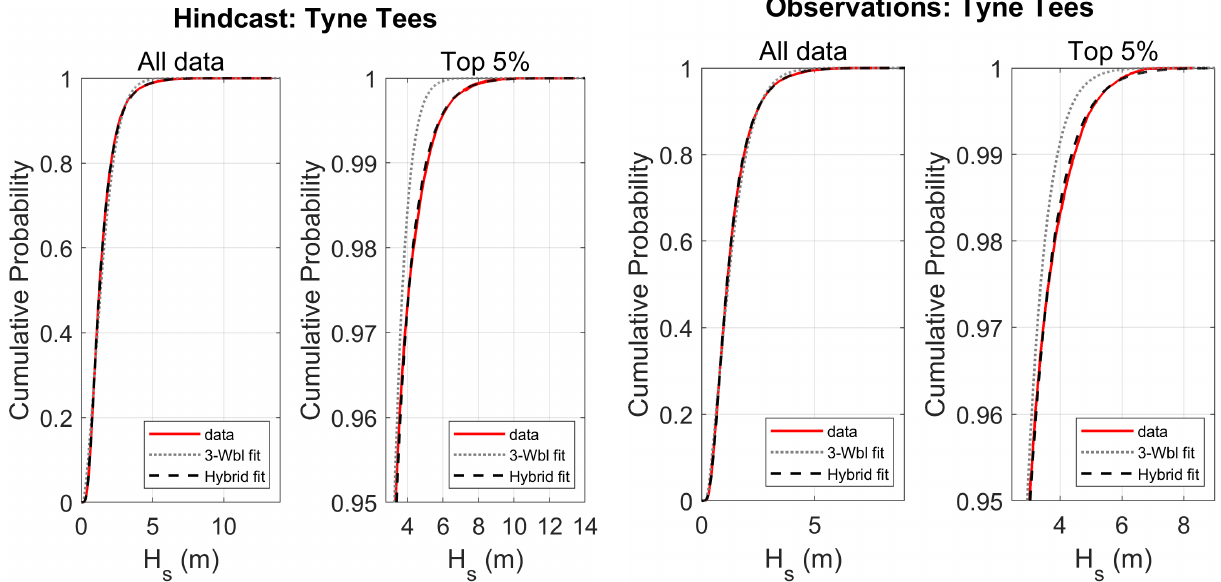
Figure 5. Goodness-of-fit plots for H s in the I-FORM method, showing both the 3-parameter Weibull fit (gray dotted line) and the hybrid fit (black dashed line). The hindcast data and observations at Tyne Tees are shown in red in their respective plots. In order to facilitate a comparison for the higher waves, a plot showing only the highest 5% of H s is given for both data